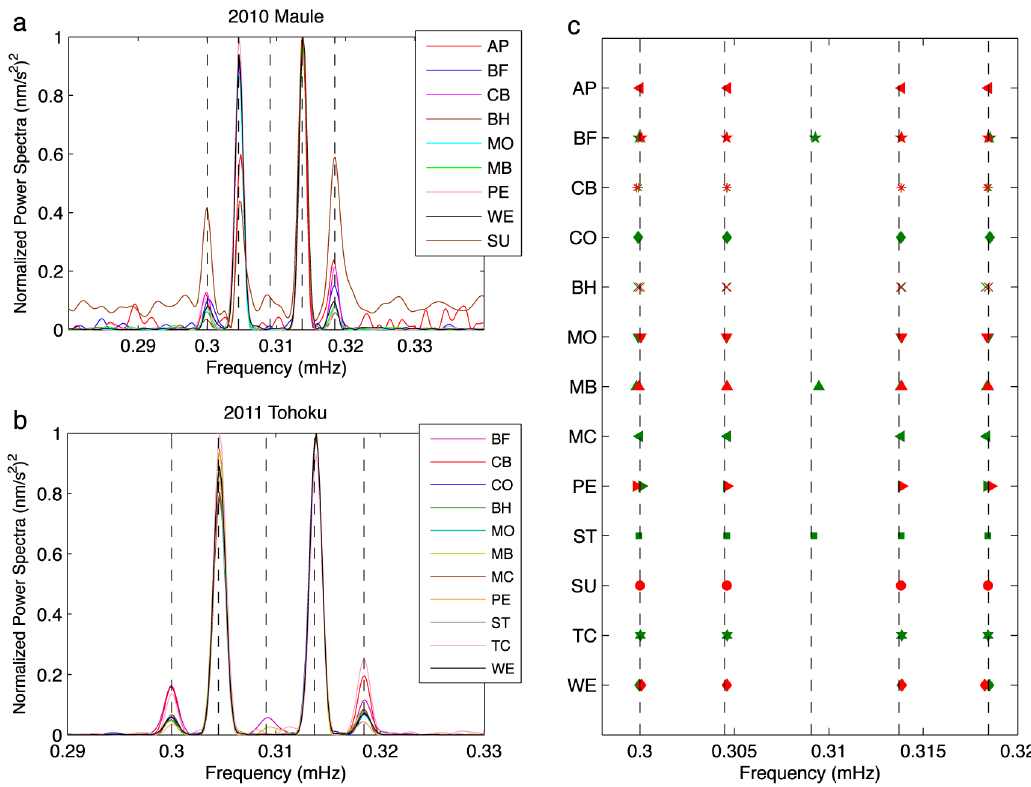
S based on the residual gravity time series after the 2010 and 2011 events. (a) The results of 9 residual grav- Figure 3. The power spectra of 0 2 ity time series after the 2010 Maule event; (b) the results of 11 residual gravity time series after the 2011 Tohoku; (c) the estimated frequen- cies from different series. The PREM predictions (from Rosat et al. [2008]) are denoted by vertical dashed lines.